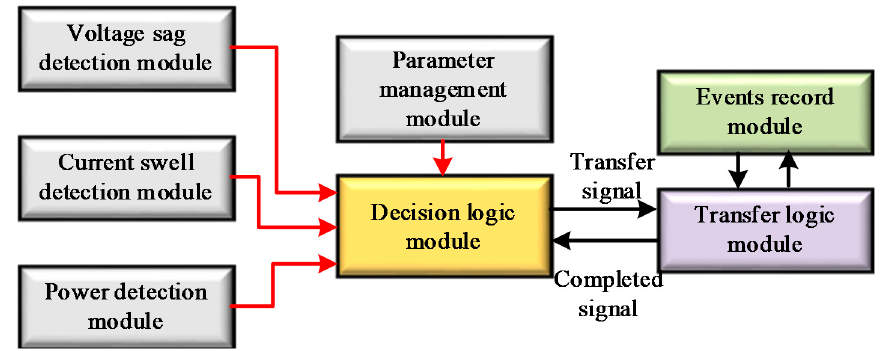
Figure 15. Block diagram for HATS [2].